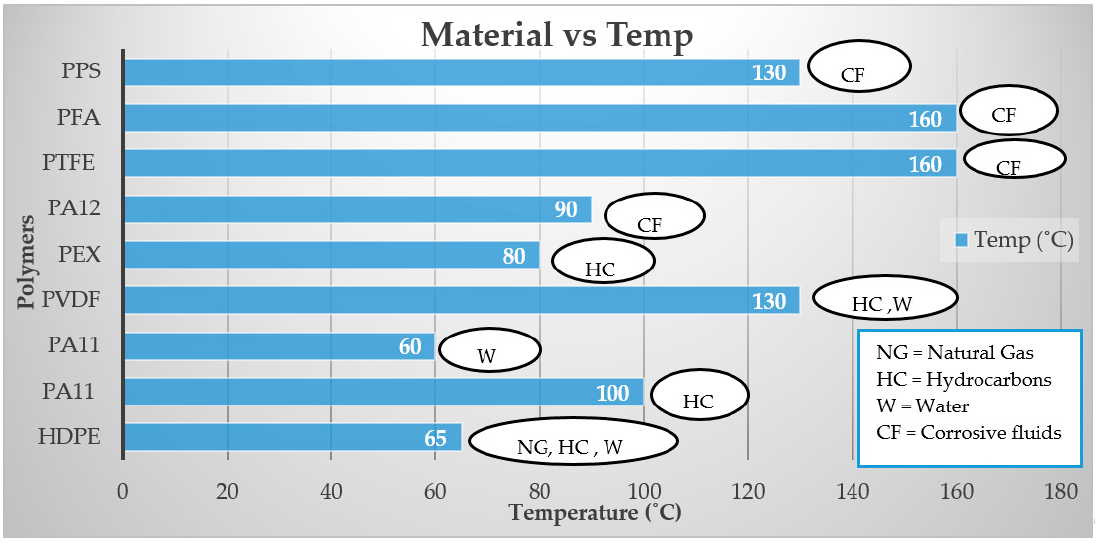
Figure 8. Temperature limits for Polymers.